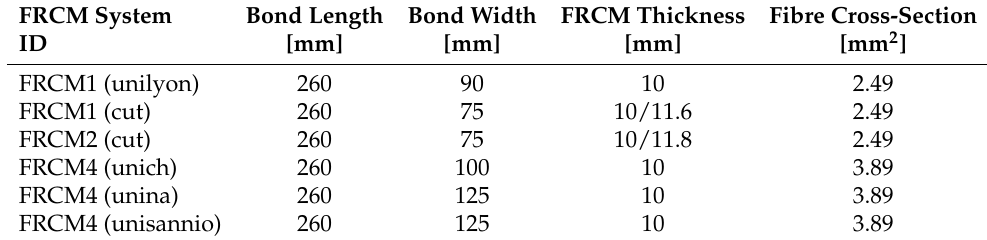
Table 3. Dimensions of the FRCM shear-bond test specimens.